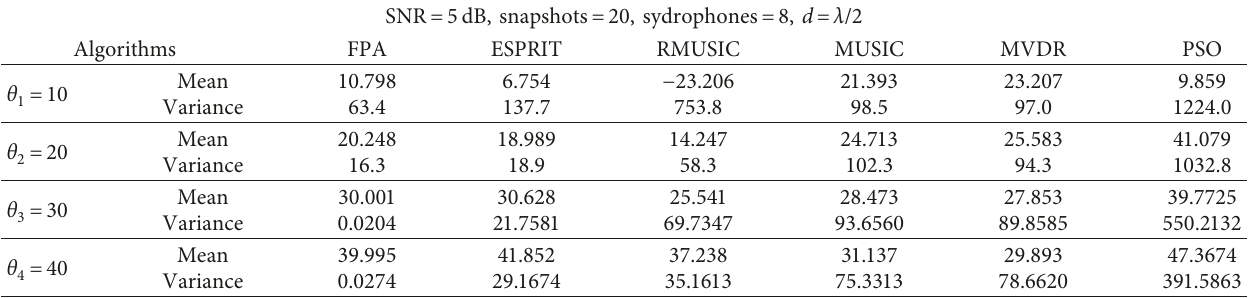
Table 3: Estimation accuracy for four sources.